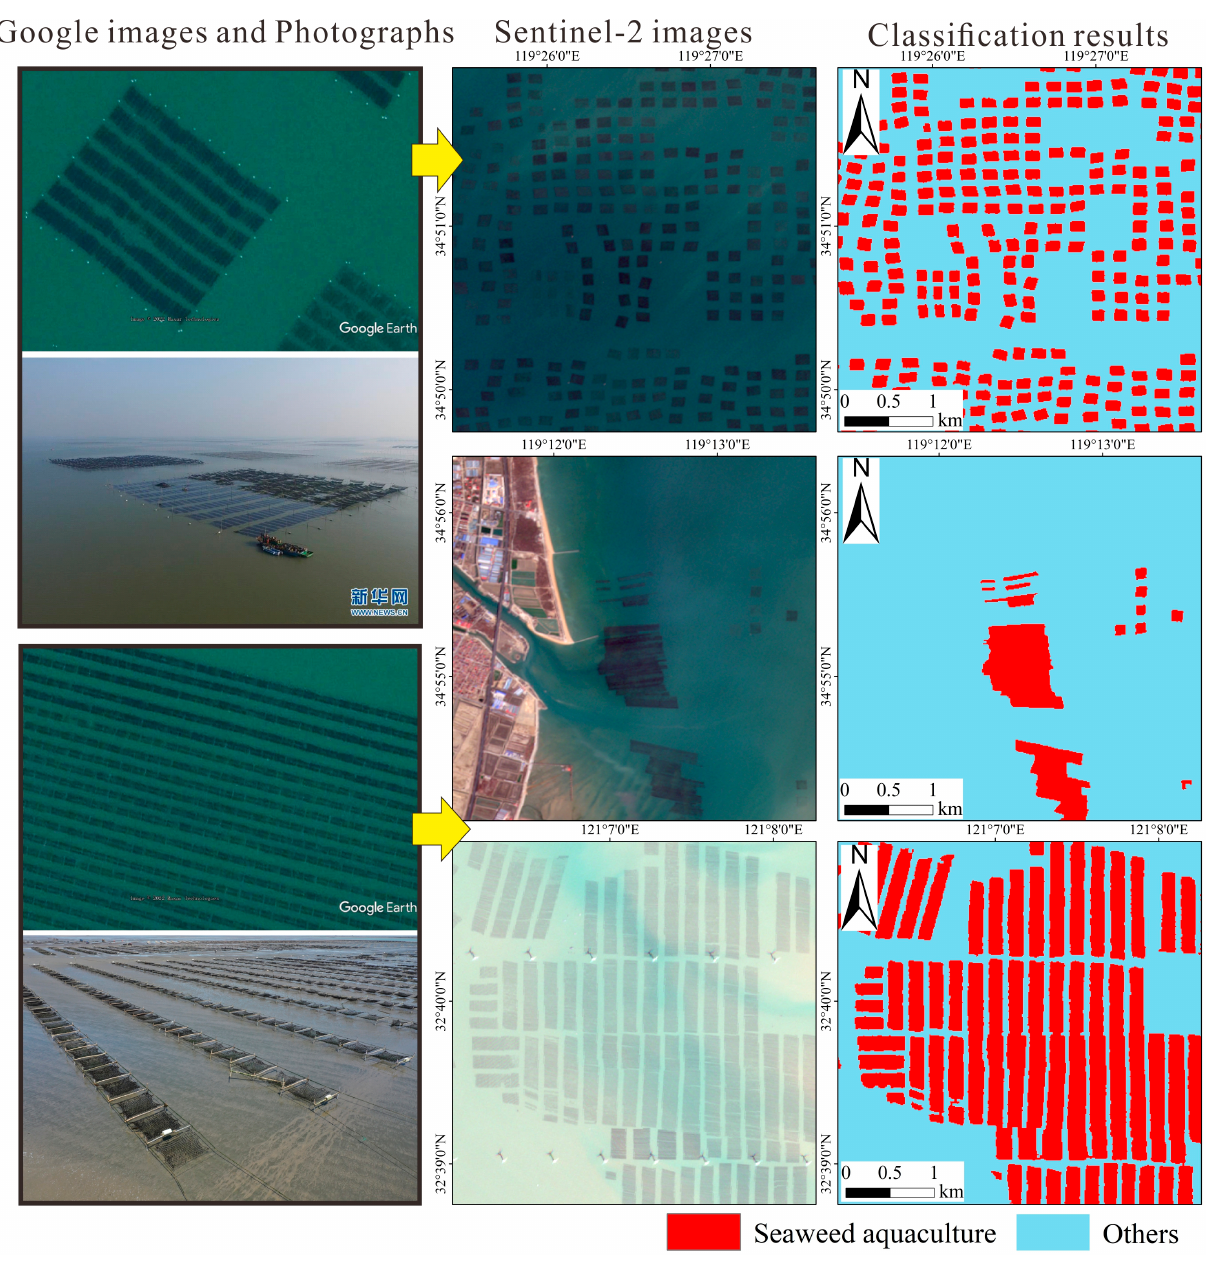
Figure 9. Display of amplified extraction results and related pictures of seaweed aquaculture (square seaweed aquaculture (Mode-I, image source: http://jingzhou.cjyun.org/p/33094.html (accessed on 8 May 2022)) and strip-shaped seaweed aquaculture (Mode-II, photograph is from field